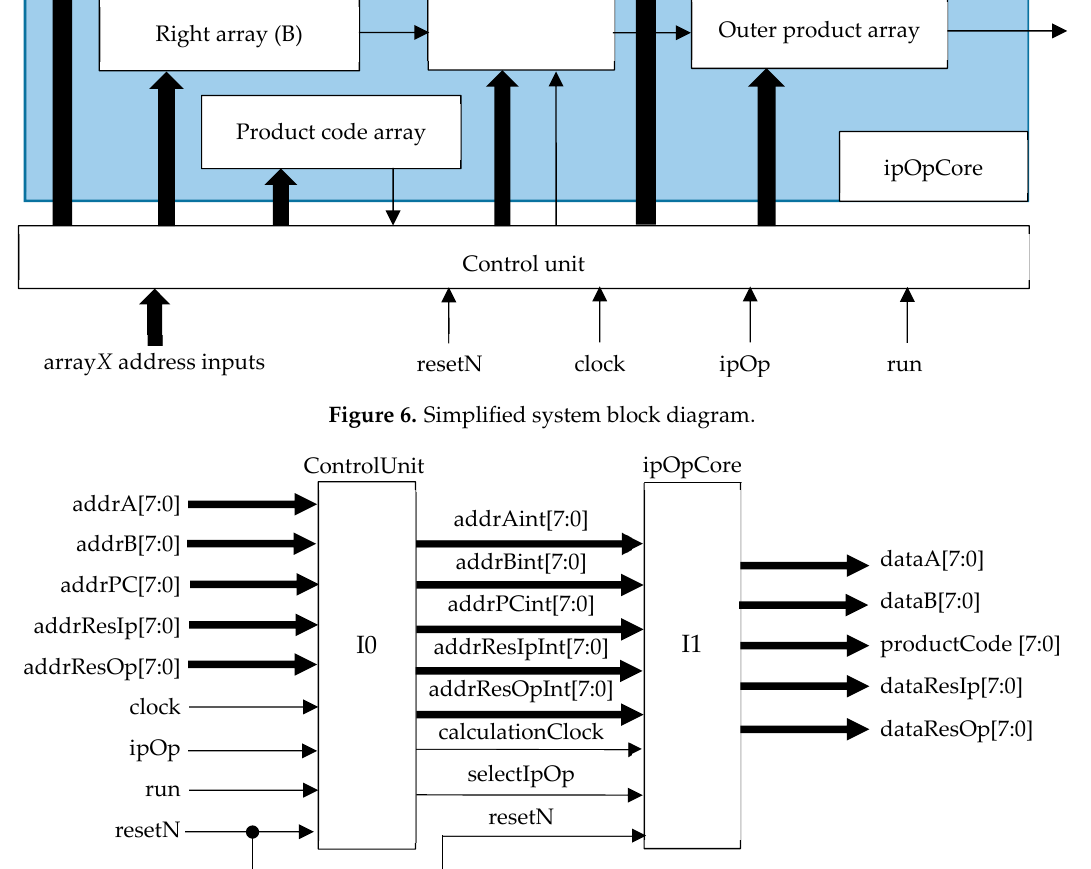
Figure 7. Simplified schematic view of the elaborated VHDL code.